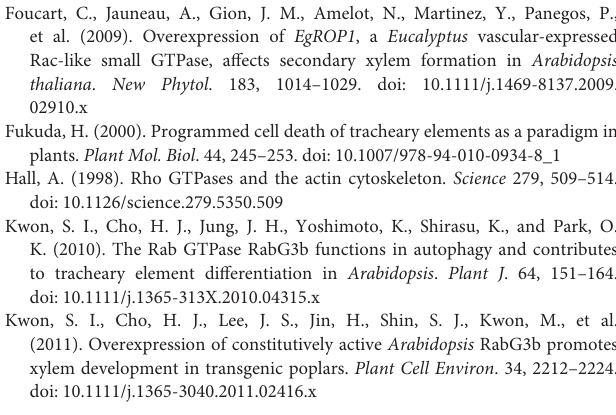
Supplementary Figure 1 | The microscopic images by confocal laser scanning microscopy (CLSM) of Rab transgenic poplars and wild type (WT). (A,B) WT; (C) OE-1; (D) OE-9; (E) QL-8; (F) QL-13. Supplementary Figure 2 | Quantitative reverse transcription PCR (qRT-PCR) analysis of xylem development-related genes in WT and transgenic lines. The poplar act in the gene was used as an internal control. Results are means ± SD of three biological replicates. Student’s t -test; ∗ P < 0.05; ∗∗ P < 0.01. Supplementary Table 1 | List of primers used in this